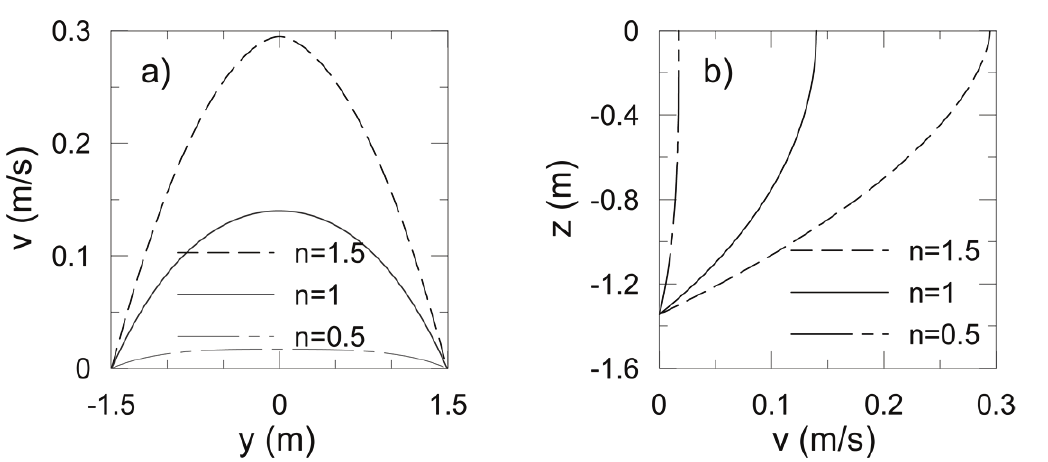
Figure 4. Velocity profiles of the channel flow of the 2001 Mount Etna eruption. a) Horizontal profiles at z = 0. b) Vertical profiles at y = 0. The velocity profiles are plotted for three different values of the power-law index n (0.5, 1, 1.5). The parameters of the Etna channel are: a = 3 m, h = 1.2–1.5 m, a = 7.5˚; the parameters of the lava are: t = 2030 kg m −3 and k = 1.1 × 10 4 Pa s n (data from Harris et al.